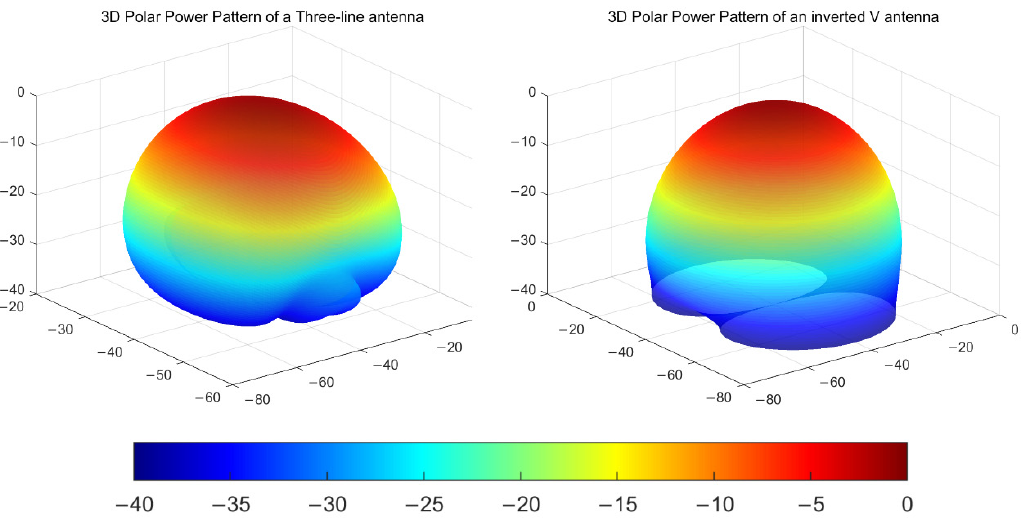
Figure 9. 3D directive gain of the antenna in the experiment. The left figure is a three-wire antenna, and the right figure is an inverted V antenna. and the right figure is an inverted V